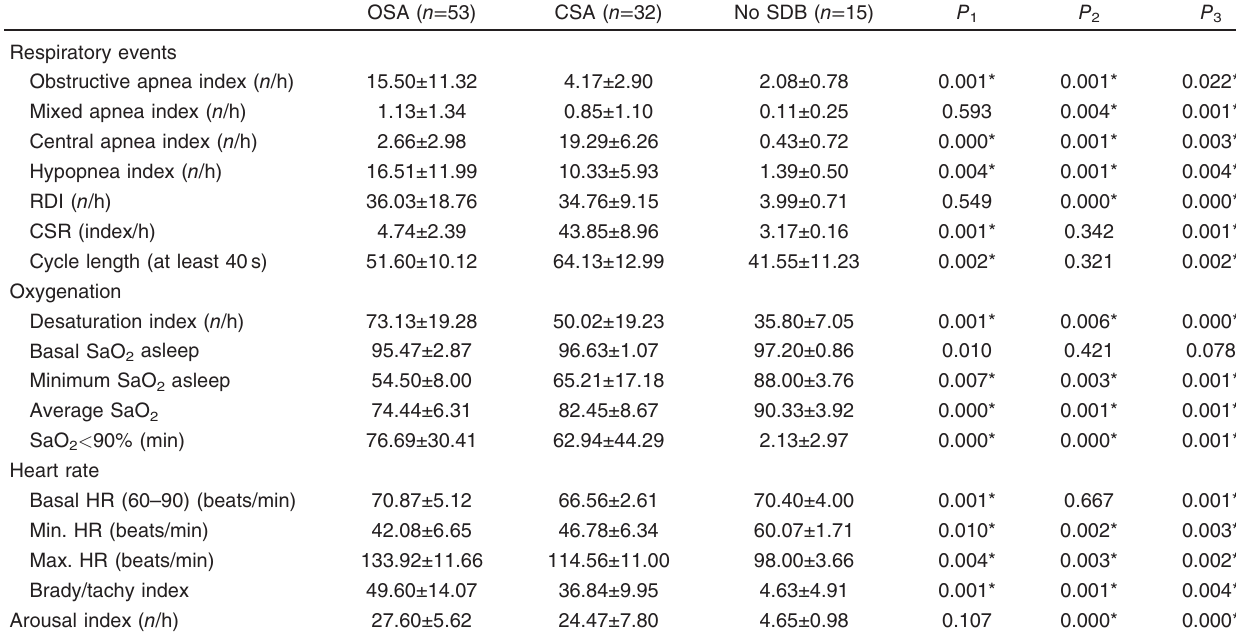
Table 5 Baseline polysomnographic parameters between obstructive sleep apnea, central sleep apnea, and no sleep-disordered breathing in heart failure patients